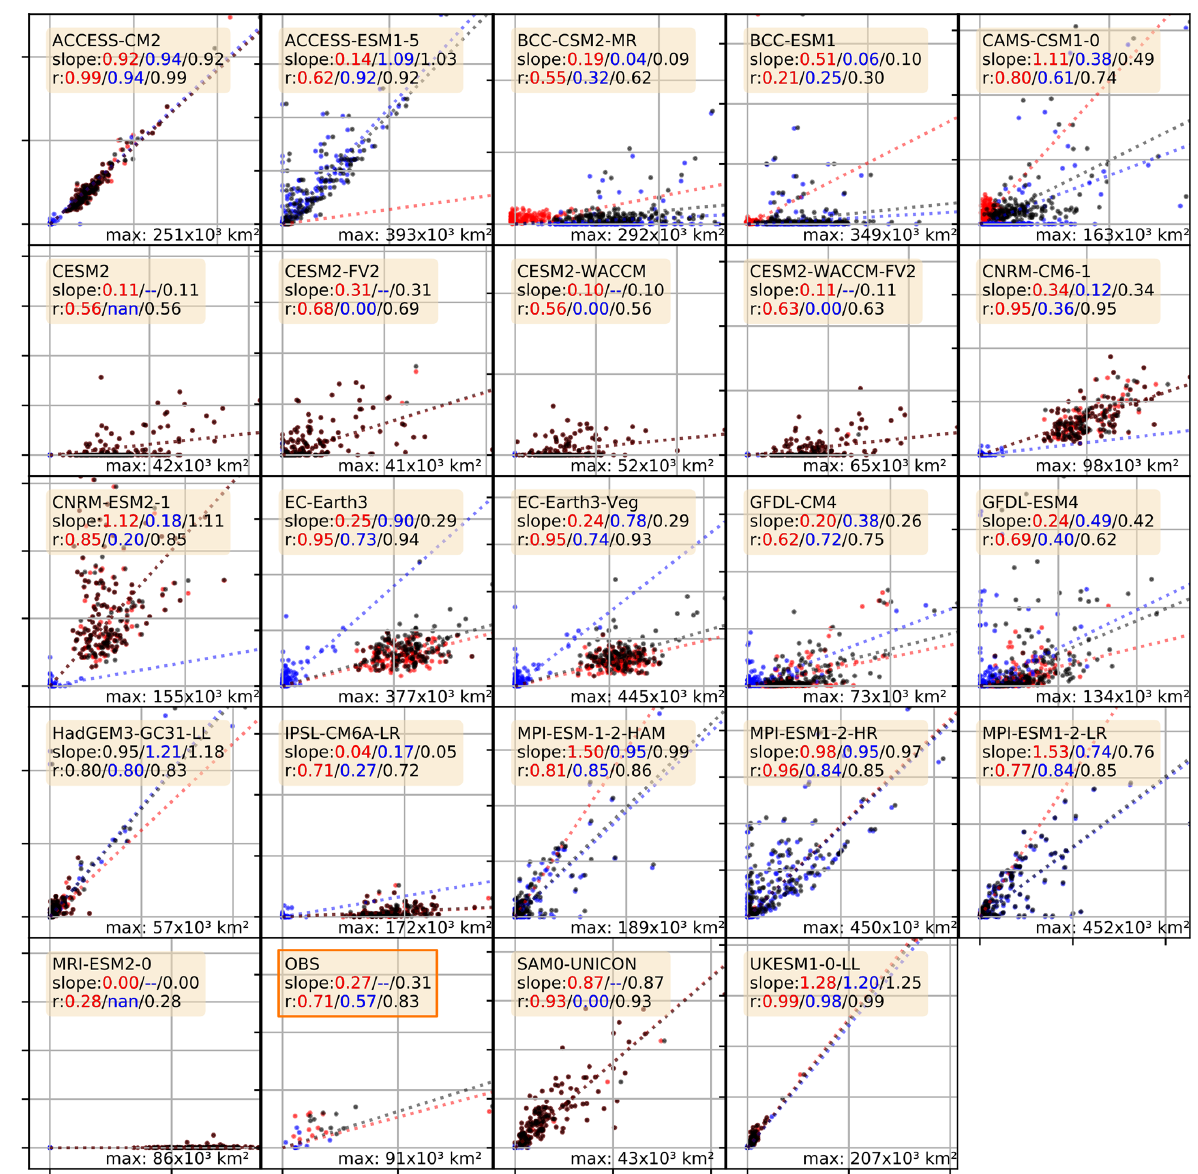
Figure A2. Correlation plots for the polynya areas computed from monthly sea ice thickness ( x ) vs. monthly sea ice concentration ( y ) as presented in Table 2. Each dot represents the averaged polynya area of 1 year; red are the coastal polynyas, blue the OWPs and black the sum of both. Where applicable (e.g. polynyas present, p value < 0.05) the legend includes the slopes of the correlation in the order coastal/open- water/combined polynyas. Because the area of polynyas varies by more than 1 order of magnitude, we normalised the axes of each plot by the highest numerical value for each model and give its value in the lower right corner of each